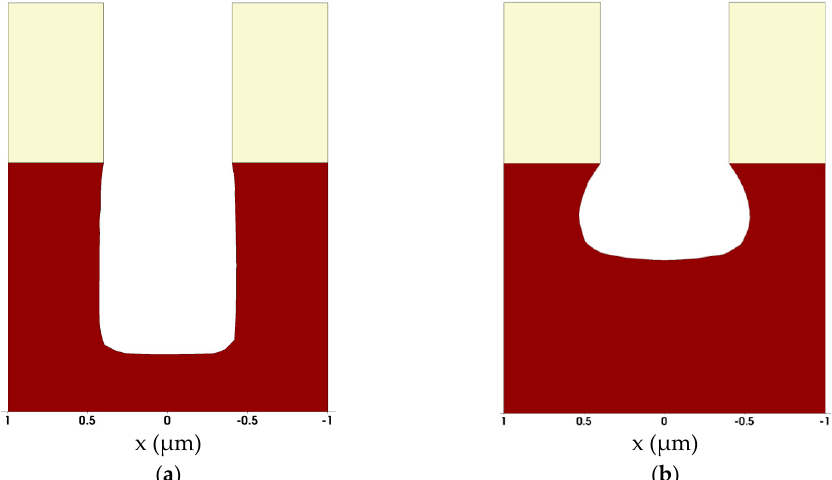
Figure 9. Example for the simulation of contact hole etching: ( a ) sputter etching with highly directional ion flux; ( b ) chemical dry etching with an isotropic angular distribution of the etching species. The material to be etched (for instance oxide) is shown in dark red. The mask which is assumed to be not affected by the etching process is depicted in yellow.